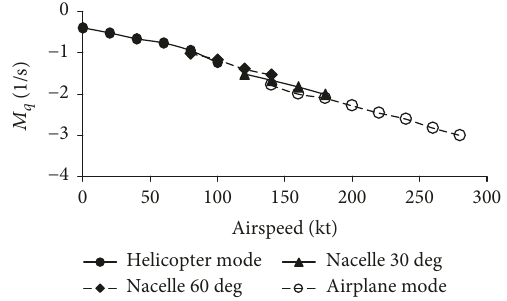
Figure 13: Variation of the derivative M